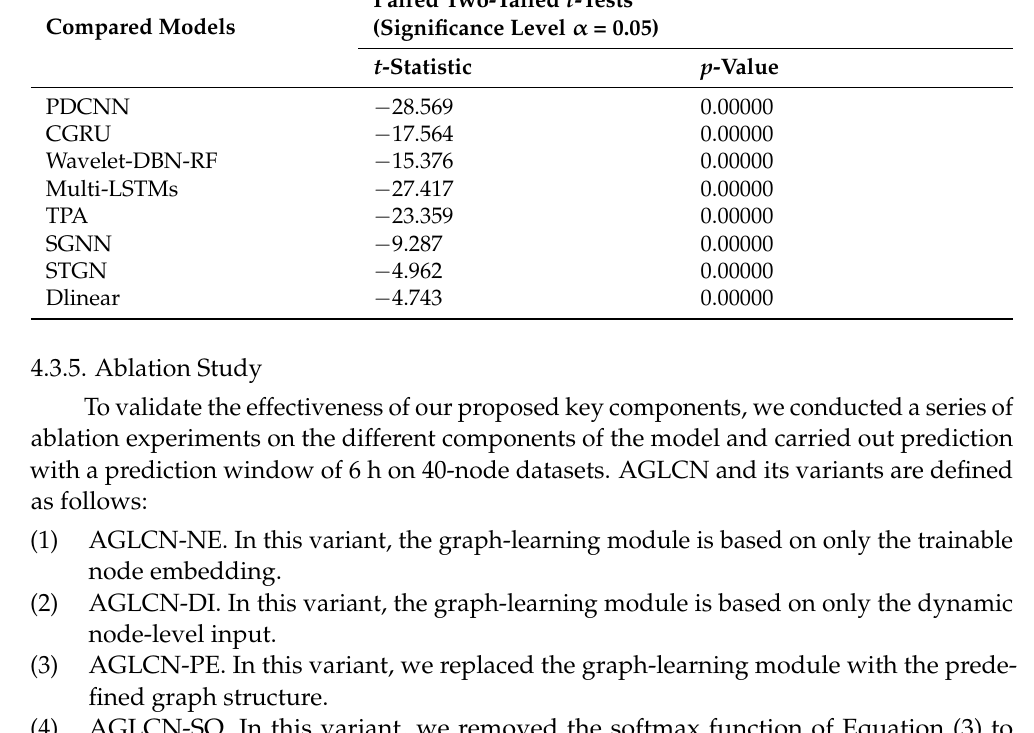
Compared Models